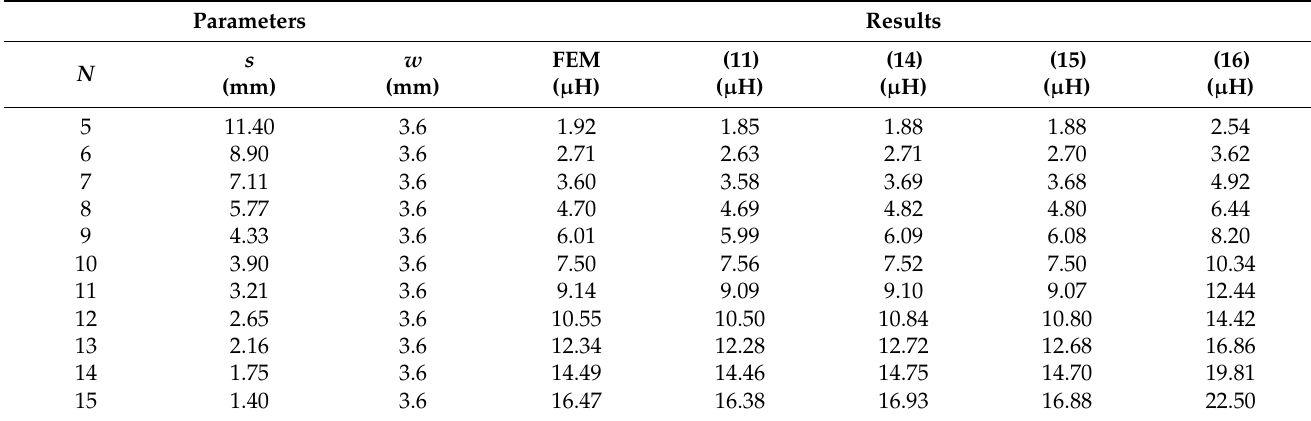
Table 3. Comparison results with different conventional self-inductance